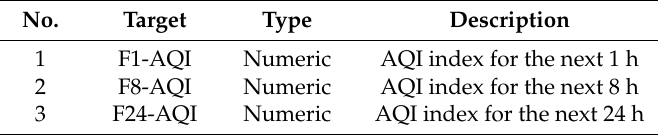
Table 2. Description of target variables.